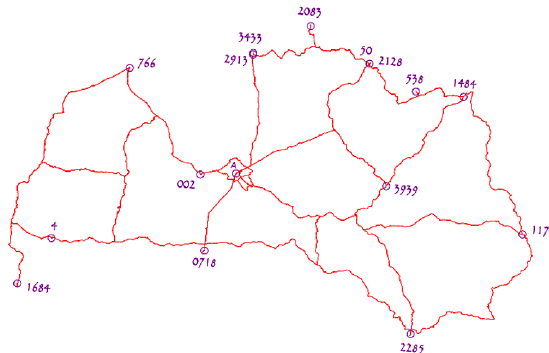
Fig. 1. 16 stabile benchmarks of EVRS realization in